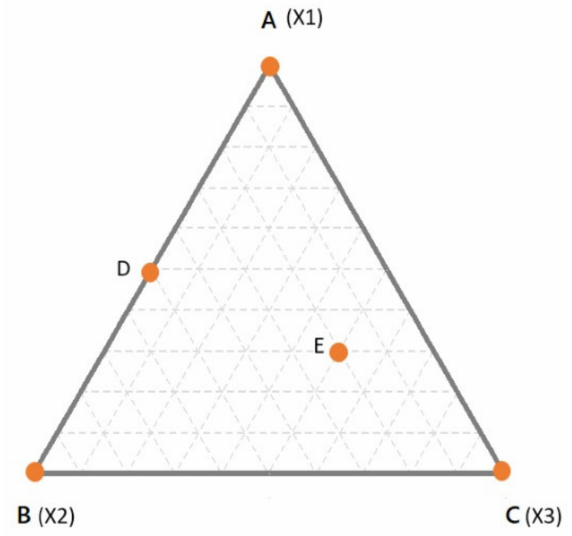
Figure 1. A simplex for a ternary mixture. Dashed lines indicate intervals of 10% of the